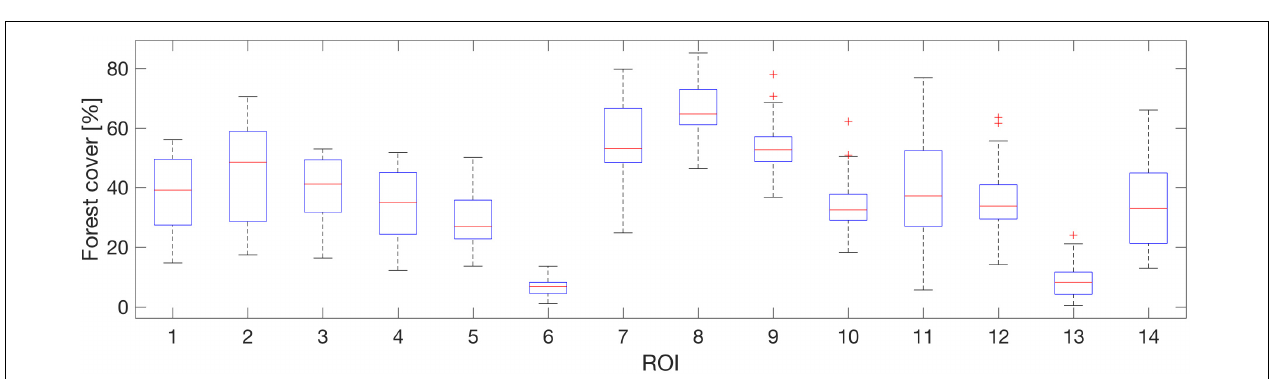
Frontiers in Earth Science |